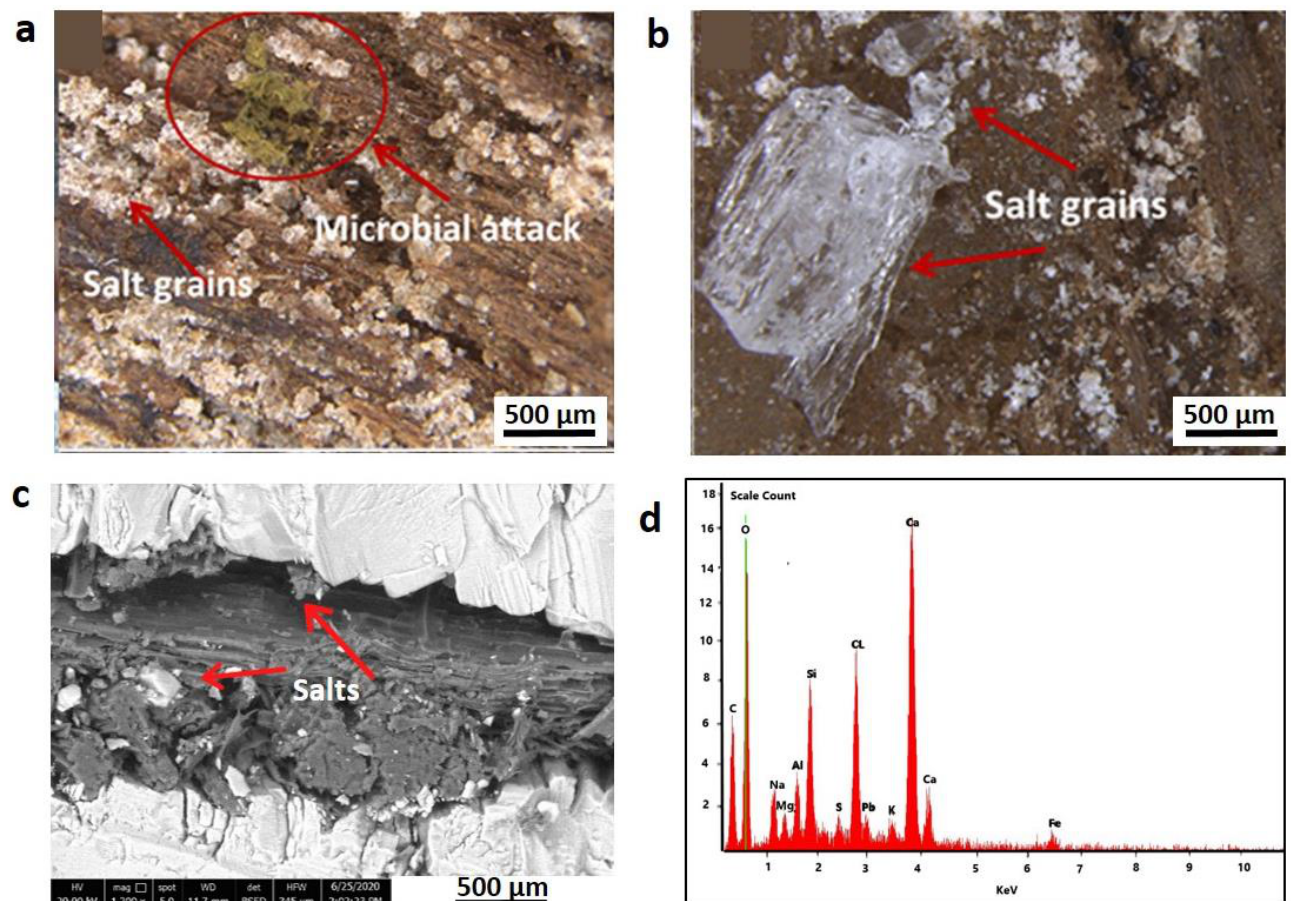
Figure 3. ( a , b ) Stereomicroscopic images (40× magnification) of wood samples #1 (pure core wooden sample) and #2 (wood interfered with soil), of the ancient statue, respectively. Salt grains and a microbial attack are visible. ( c ) SEM image (magnification 1200×) of sample #2 shows the crystalised salt dispersed on the wood sample. ( d ) EDX average spectrum of sample #1.